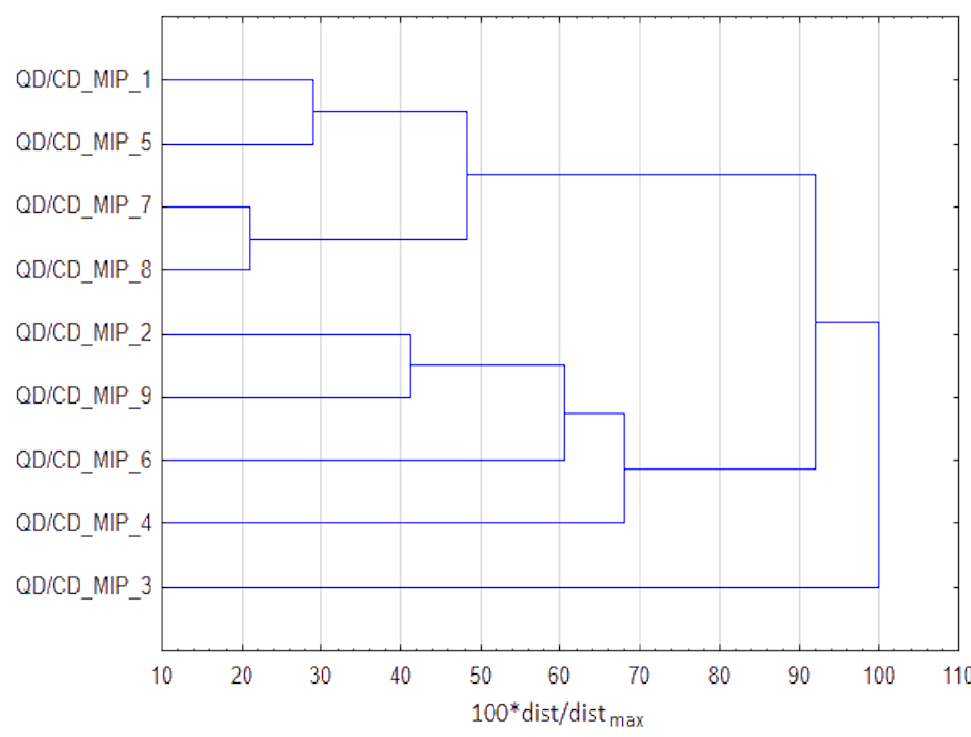
Figure 7 . Grouping of procedures based on quantum or carbon dots, obtained with cluster analysis. Figure 7. Grouping of procedures based on quantum or carbon dots, obtained with cluster